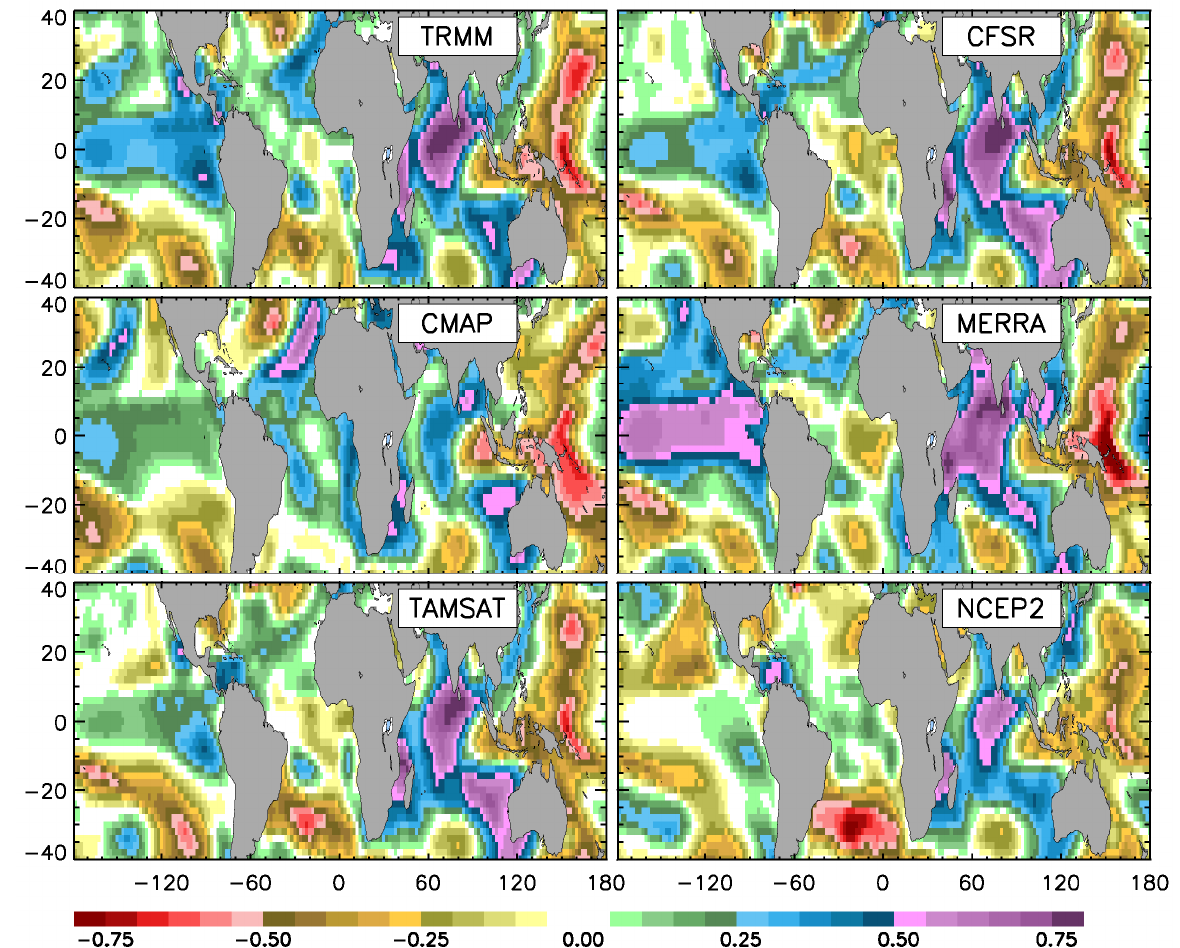
Figure 18. Correlation between November rainfall over the Lake Victoria catchment (area shown on map) and November SSTs for three satellite products and three reanalysis products: The 10% significance level is 0.37 and the 5% significance level is 0.43.